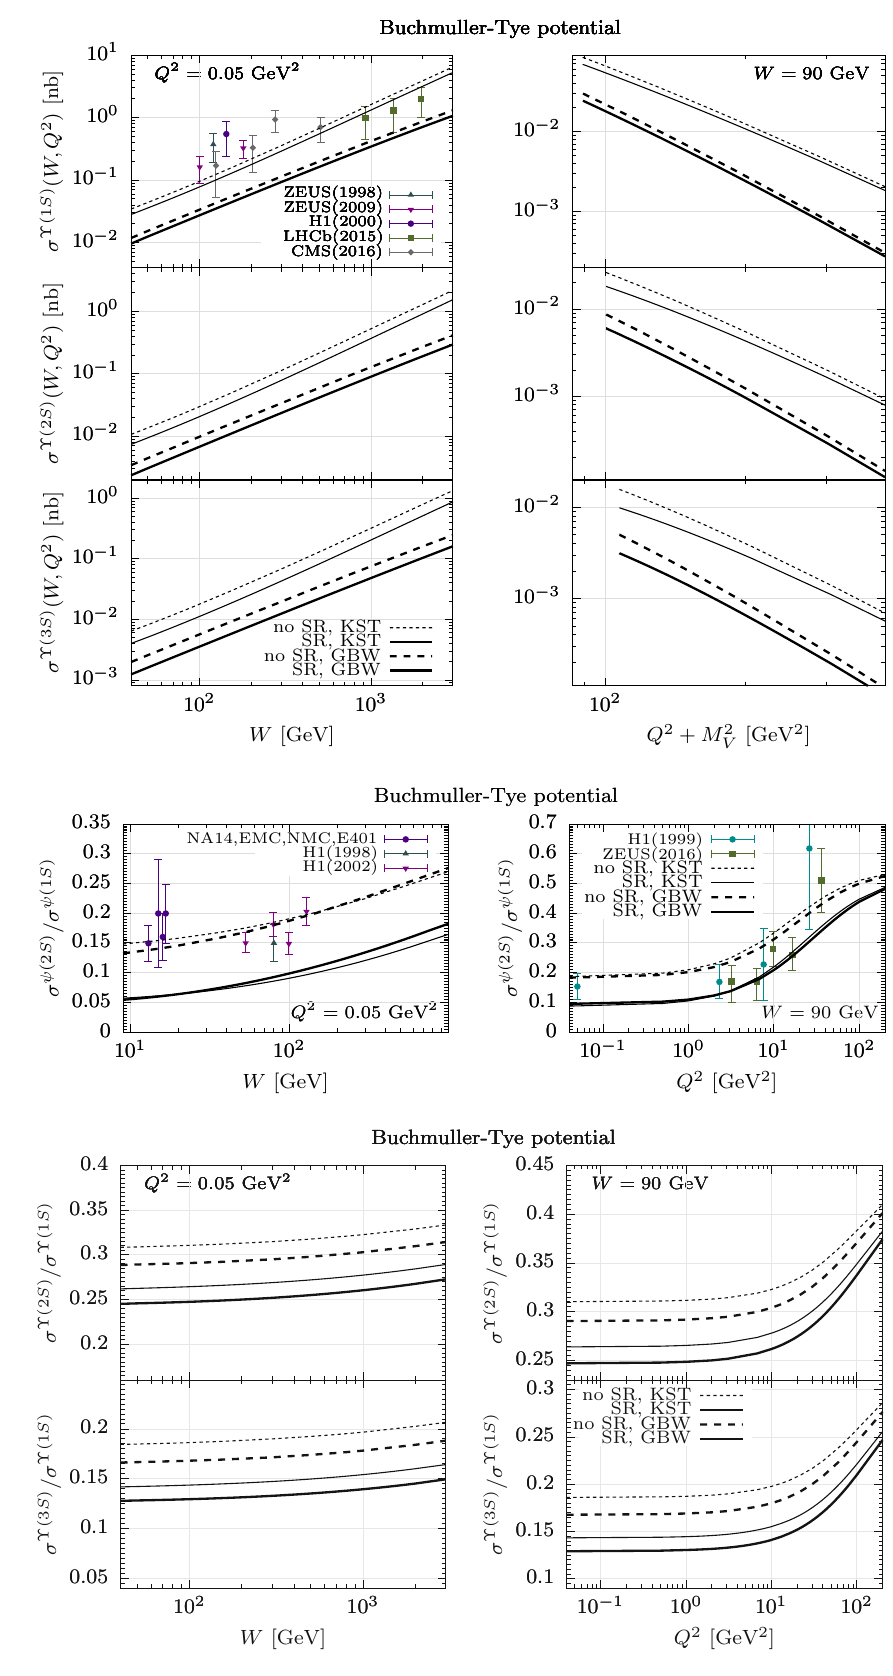
Fig. 4 The same as Fig. 1 but for the electroproduction of ϒ( 1 S ) (upper panels), ϒ (cid:4) ( 2 S ) (middle panels) and ϒ (cid:4)(cid:4) ( 3 S ) (lower panels) states. The experimental data for γ p → ϒ p process are from Refs. [25,48–51]. Here, the radial wave functions of ϒ( 1 S ) , ϒ (cid:4) ( 2 S ) and ϒ (cid:4)(cid:4) ( 3 S ) states are generated by the BT potential [36]